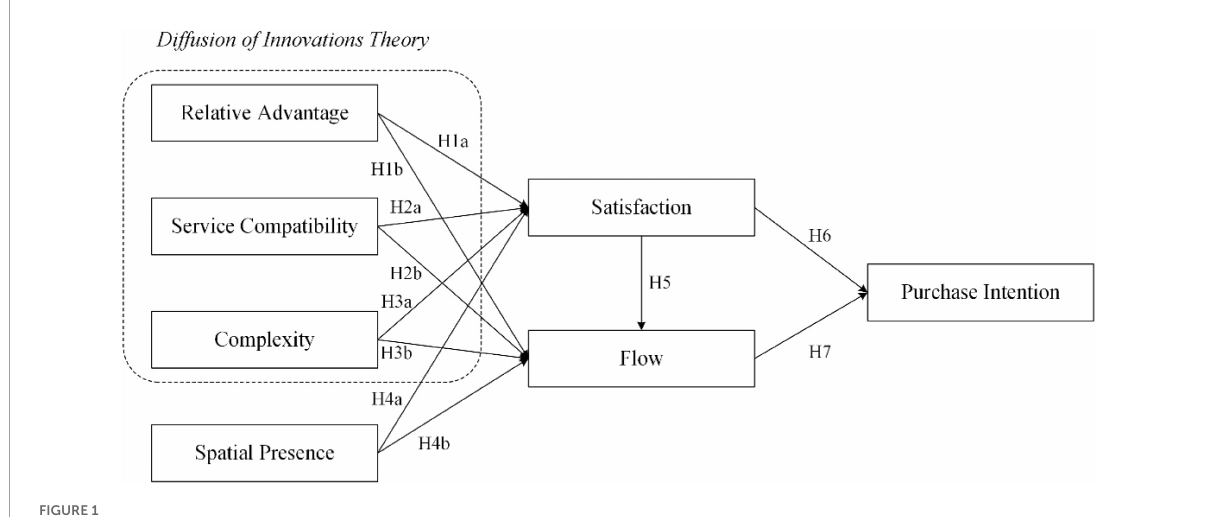
FIGURE1 Research